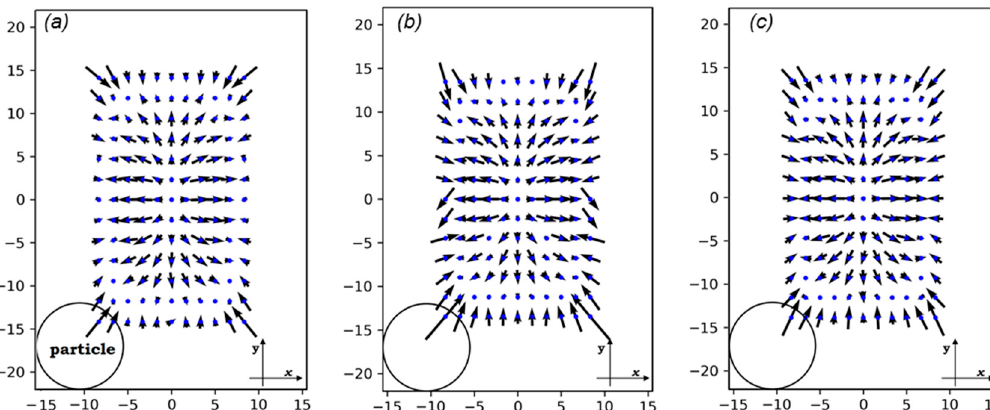
Figure 6. The lift forces on three different cross-sections: ( a ) on x = 20 μ m, ( b ) on x = 0, and ( c ) on x 0 = 88.32 μ m (see Figure 3). The x-y coordinate is a local coordinate whose dimensions are shown on each rectangle. The circle only exhibits the scale of the particle dimensions in comparison with those of the channel. All dimensions are in μ m.